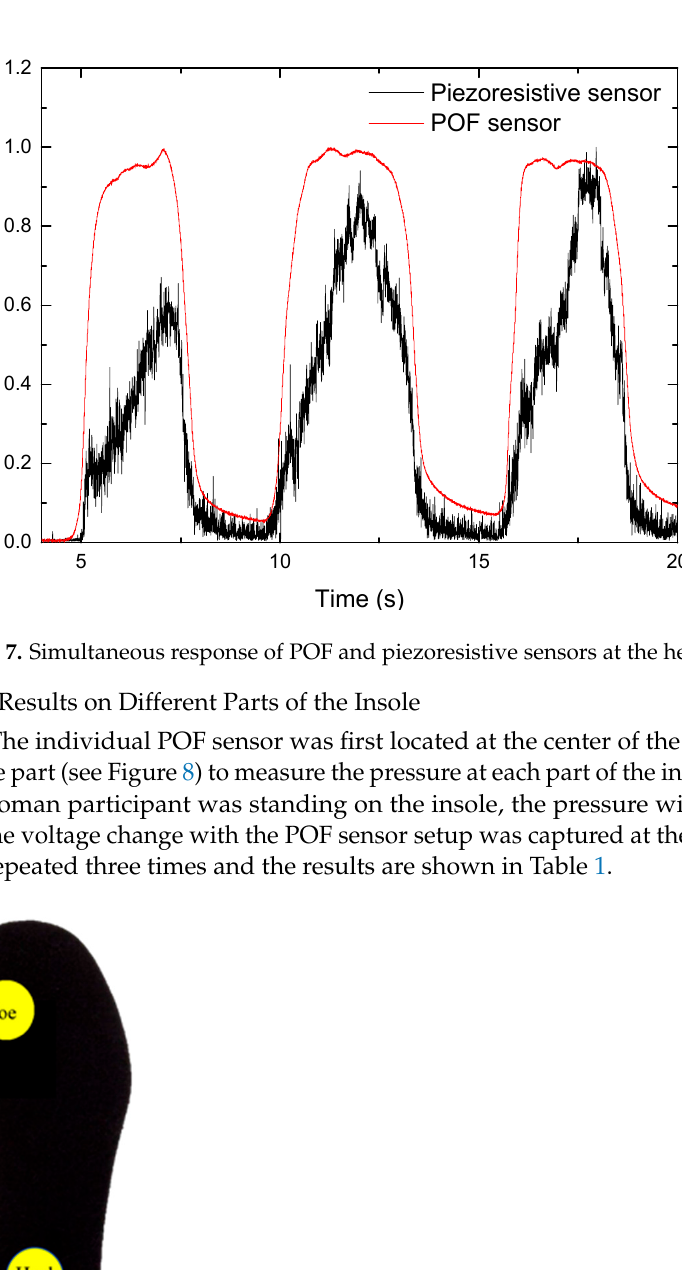
Figure 7. Simultaneous response of POF and piezoresistive sensors at the heel part of the insole.